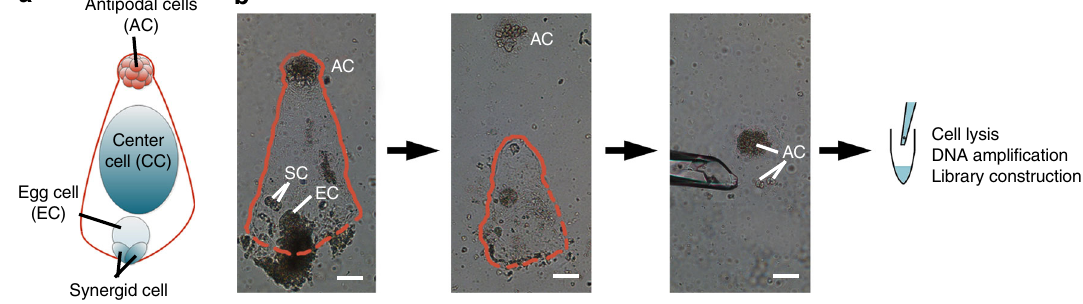
Fig. 1 The microscopic isolation of antipodal cells from maize embryo sac. a A diagram of a mature embryo sac. b The brief steps of microscopic isolation. The red line pro fi les embryo sac putatively. Bar = 100 μ